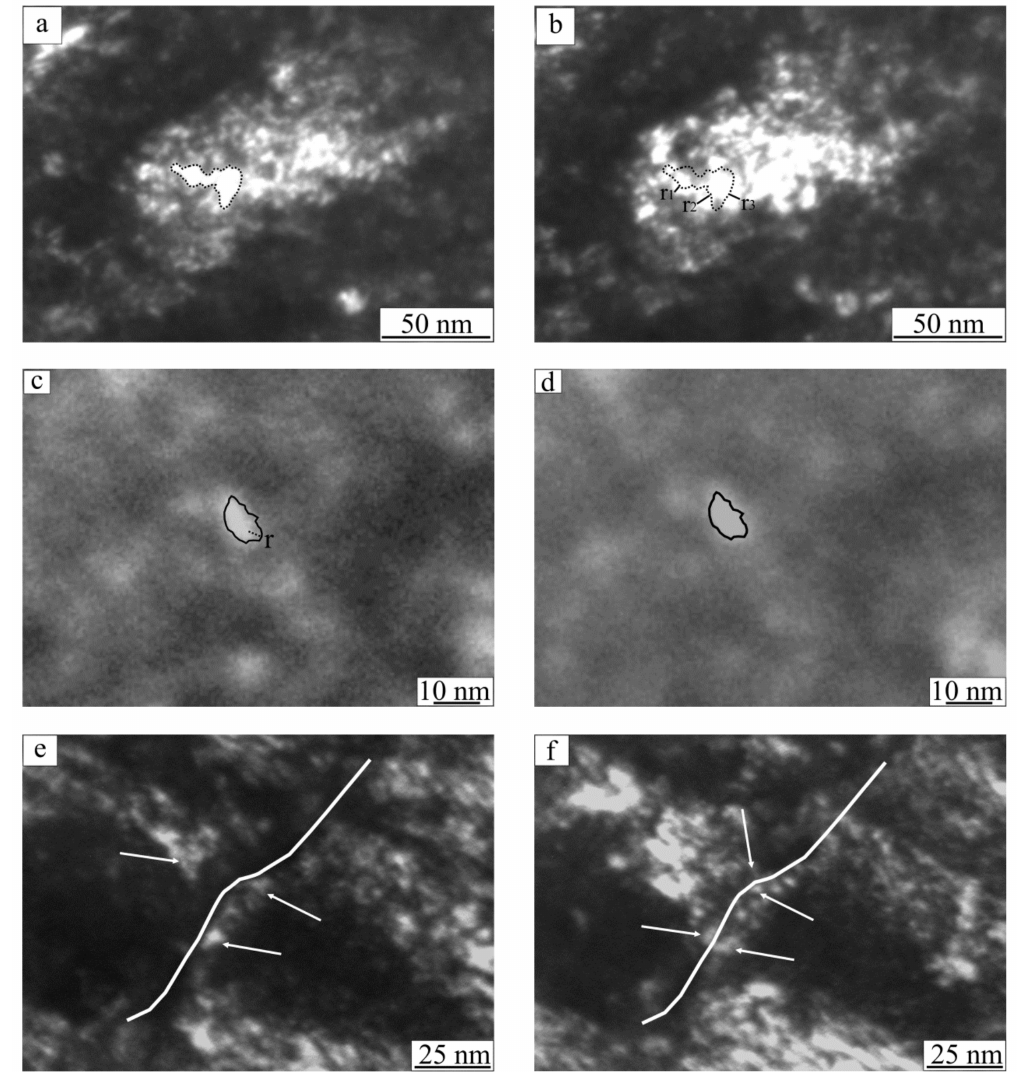
Figure 5. Dark-field images of bending extinction contour displacement characterizing the bending of the crystal lattice in columnar ( a , b ) and nanocrystalline ( c , d ) structures and misorientation of the reflecting planes of <220> type at the boundary of the alloyed and non-alloyed nitride ( e , f ) (lines and arrows denote extinction contours; their displacements are denoted by lines with letters; the boundaries in ( e ) and ( f ) are denoted by a white